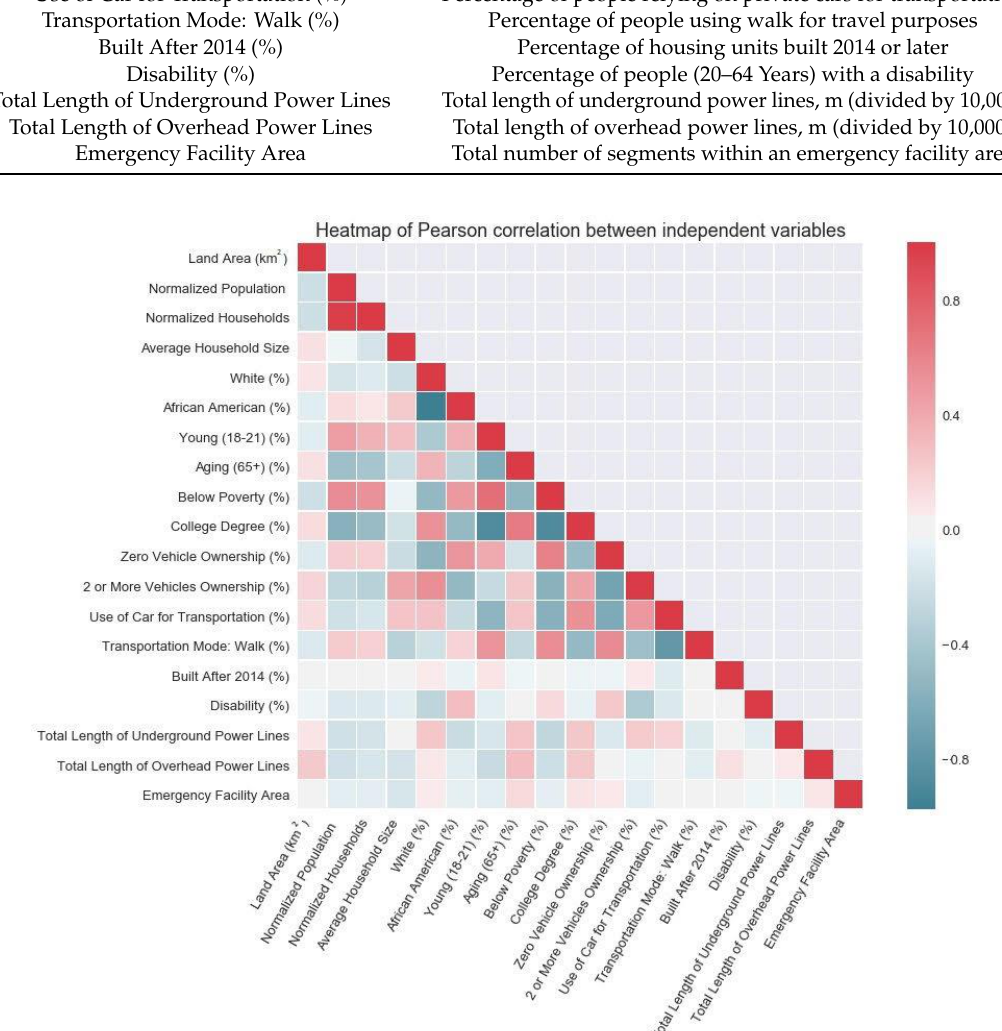
Figure 4. Correlation matrix of independent variables.